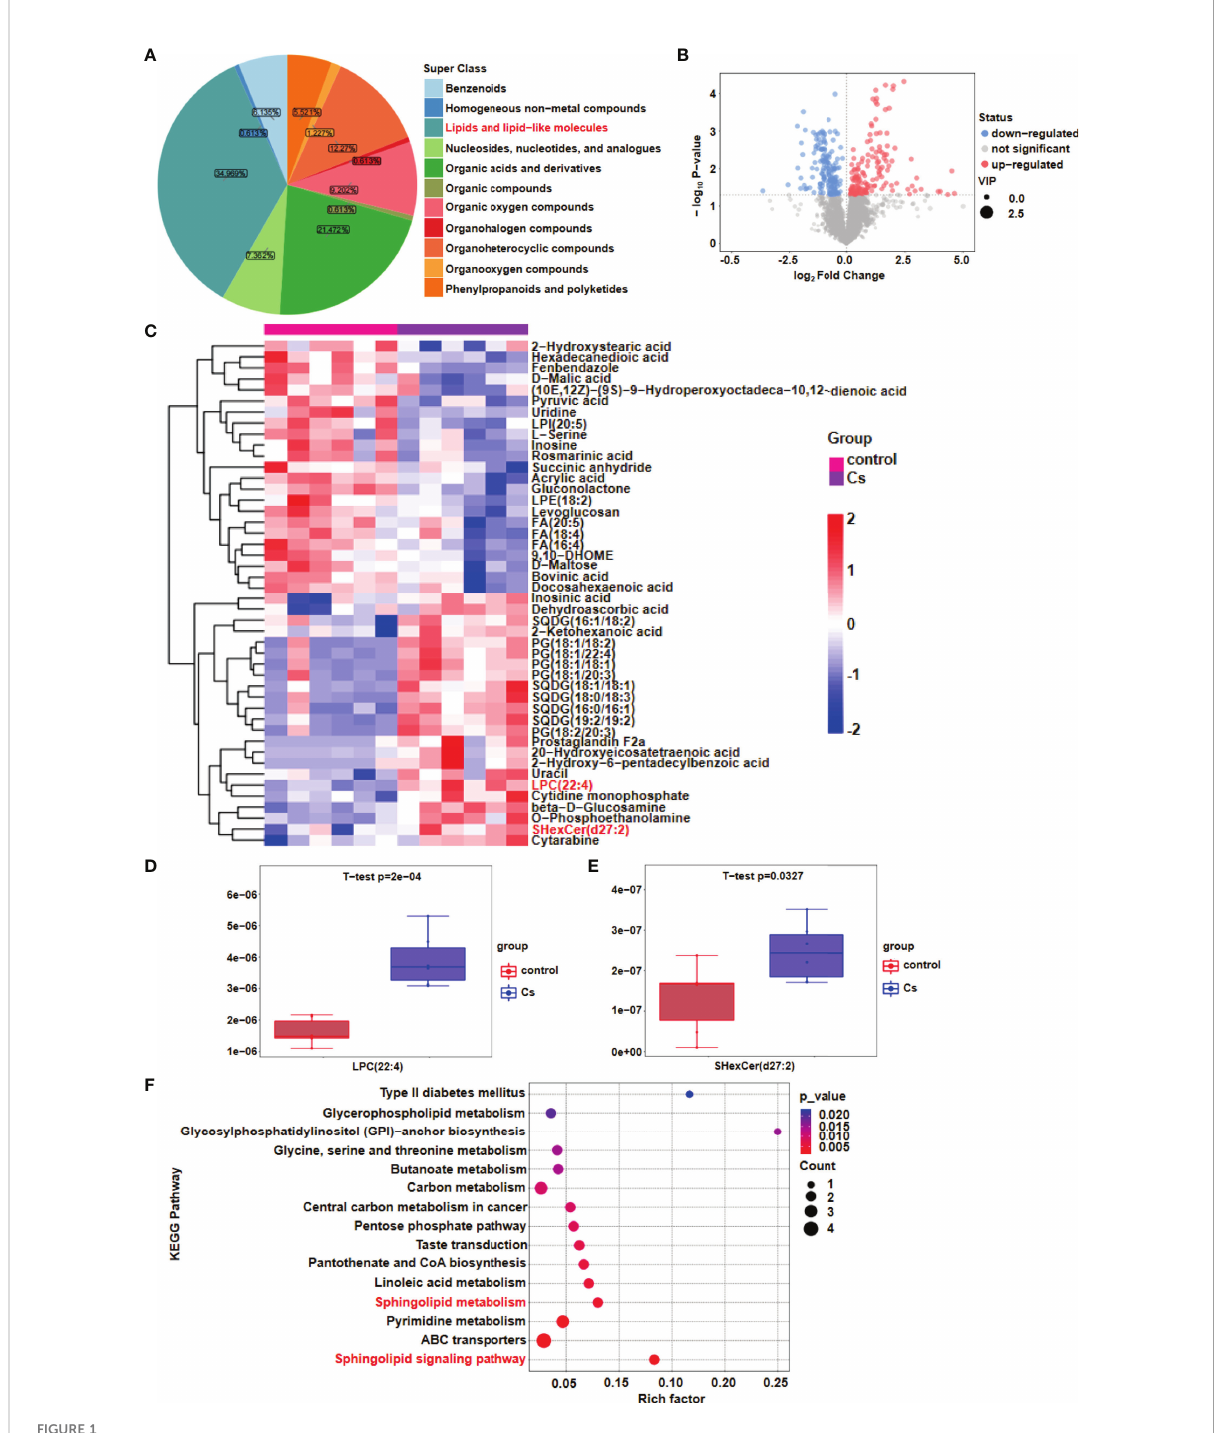
FIGURE 1 Lipid metabolism changes after C. sinensis infection. (A) Pie plot of metabolite classi fi cation and proportion. (B) Volcano plot for the C. sinensis - infected group vs the control group by metabolomics. (C) Heatmap of hierarchical clustering analysis for the C. sinensis -infected group vs the control group by metabolomics. (D) Boxplot displays a quantitative analysis of metabolite content of LPC for the C. sinensis -infected group vs the control group by metabolomics. (E) Boxplot displays a quantitative analysis of metabolite content of SHexCer for the C sinensis -infected group vs the control group by metabolomics. (F) KEGG Pathway Analysis for the C. sinensis -infected group vs the control group by